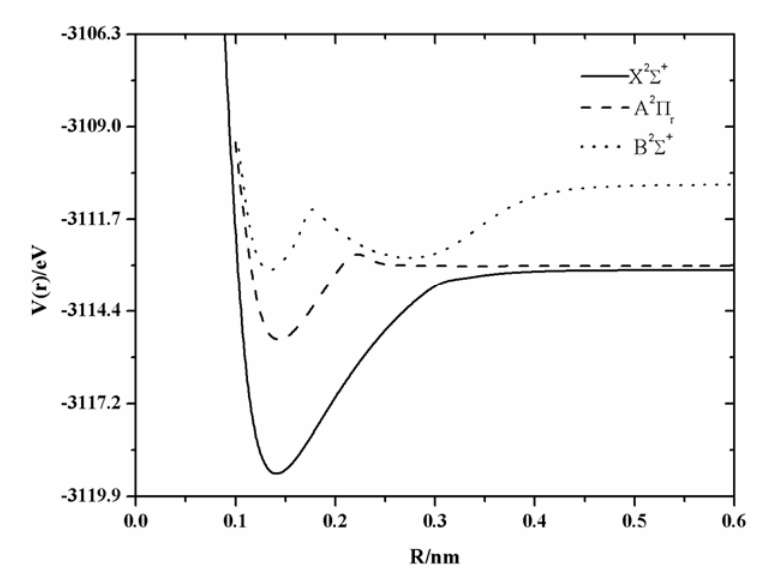
Figure 1. Potential energy curves (PECs) of the BeF.